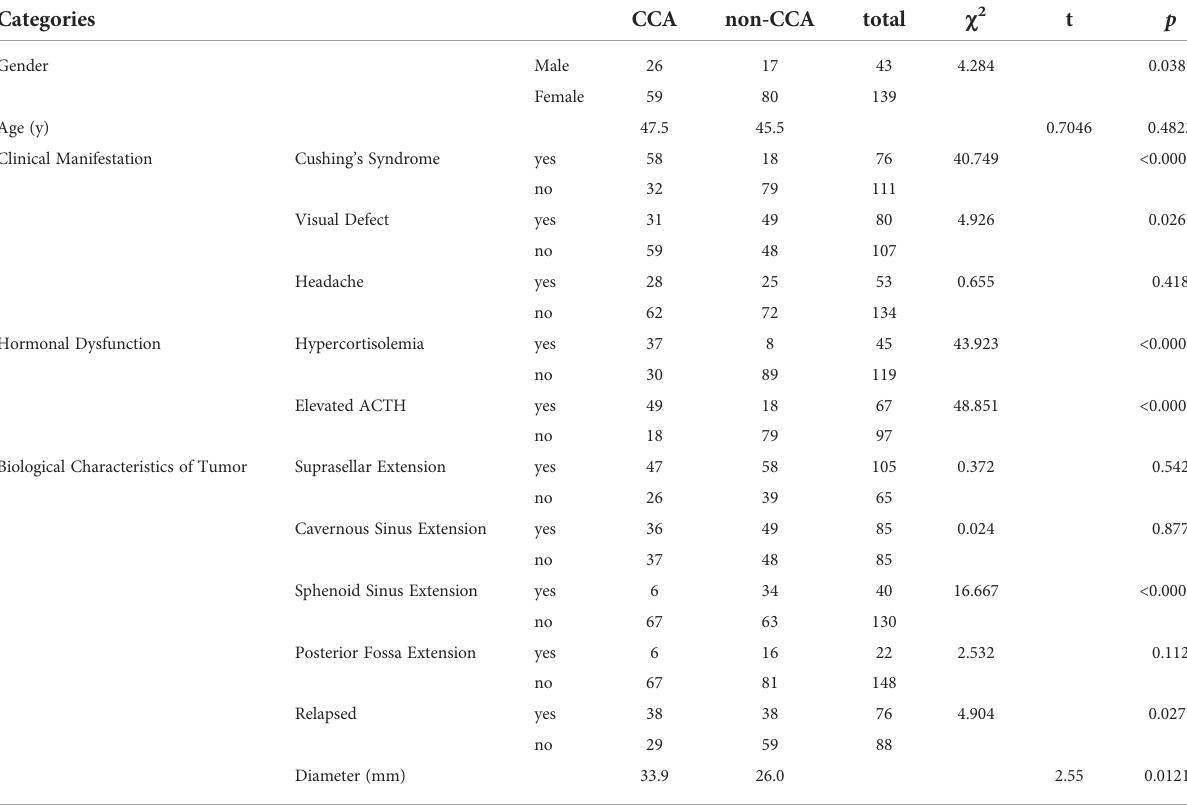
TABLE 5 Relationship between tumor type and clinical